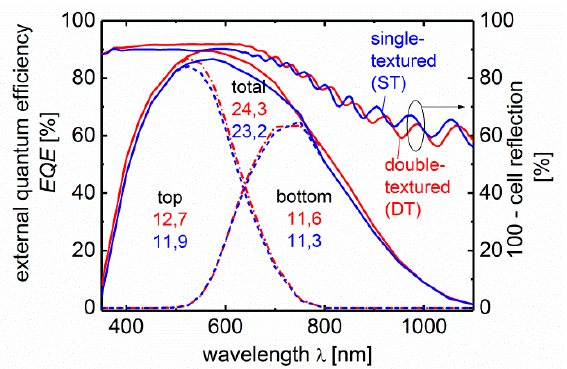
Figure 8. EQE and cell absorption (100%—cell reflection) of single-textured (ST) HCl etched sample (blue lines) and double-textured (DT) HCl + subsequent HF-dip with improved light-coupling (red lines). The calculated top and bottom cell short-circuit current-densities [mA / cm 2 ] are indicated in the graph. Best cell on each substrate shown respectively.